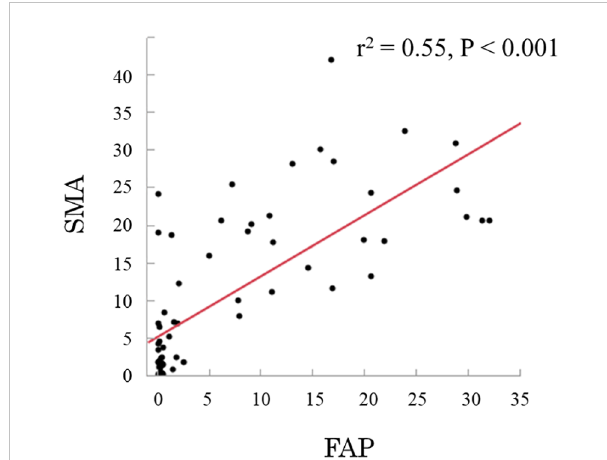
FIGURE 3 Relationship between smooth muscle actin ( a -SMA) and fi broblast activation protein (FAP), showing a linear correlation (r 2 = 0.55; p < 0.001).